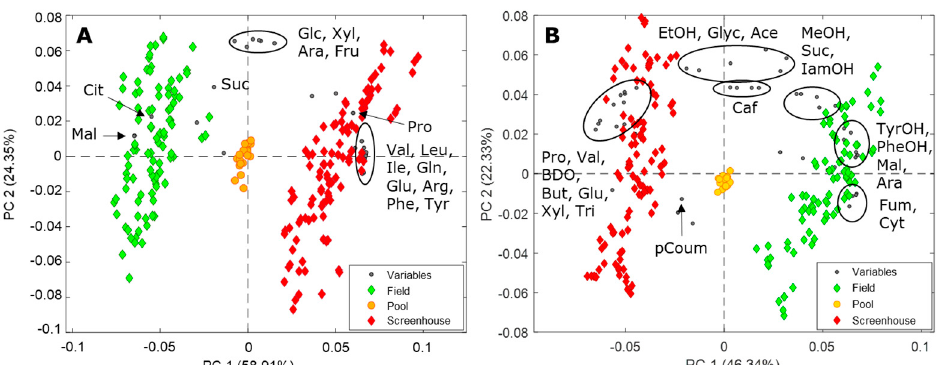
Figure 4. Biplots of the PCA performed on the metabolite concentrations in must ( A ) and wine ( B ) samples from the field and screenhouse trials. Keys. Ace: acetate; Ara: arabinose; Arg: arginine;